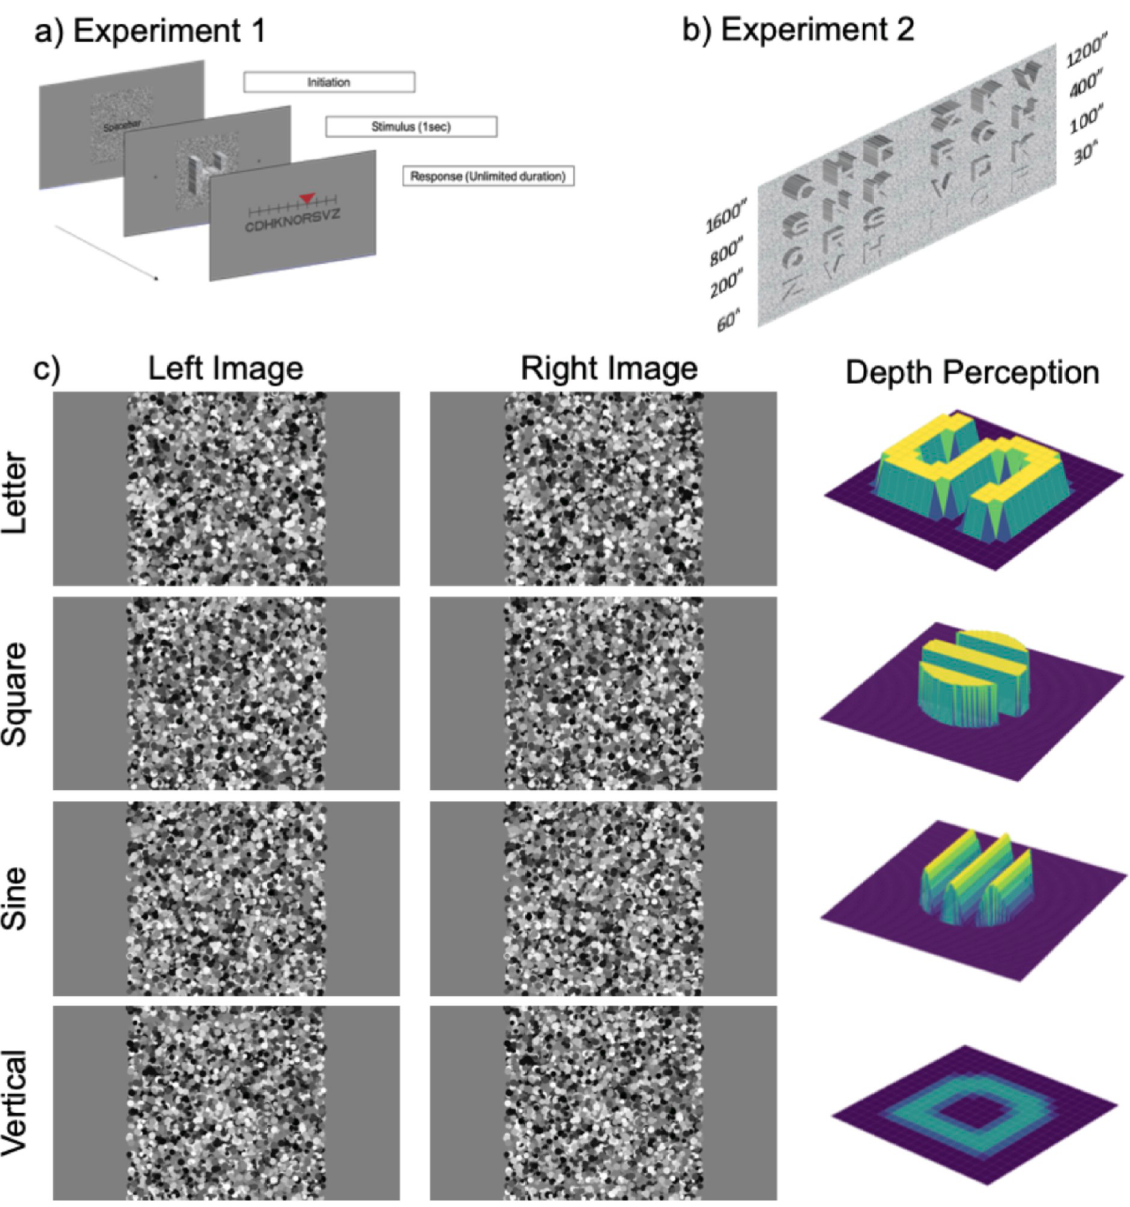
Fig 2. Experimental set-up and stimulus. a) Sequence of stimulus presentation in Experiment 1. The single letter appears in depth embedded in Random Dot Stereogram for 1 sec, followed by a response page. Subjects used the arrow keys to select the letter seen in the previous slide. b) Illustration of the near stereo letter chart in Experiment 2. Each page corresponds to one spatial frequency or letter size. On each page, the letters are presented in trigrams (four rows and two columns). Within each triplet, all letters have the same disparity with a total of eight disparity steps tested. The disparity steps, in arc seconds, were listed next to each set of trigrams (not shown during the experiment). Subjects read the letters aloud from left to right starting from the top row. c) Example of stereo stimuli used in Experiment 2 and 3. By fusing the left and right images, readers can see a letter “S” appearing in depth (crossed disparity or front) as illustrated in the rightmost column. In Experiment 3, we included square and sinewave depth corrugations in a circular patch. The sine gratings have disparity gradient, while square gratings have an “all or none” disparity profile. In the last row, readers can appreciate the letter “D” presented with a vertical disparity. Letters with vertical disparity do not appear to “pop-out” or “cave-in,” but rather have a shimmering luster appearance.